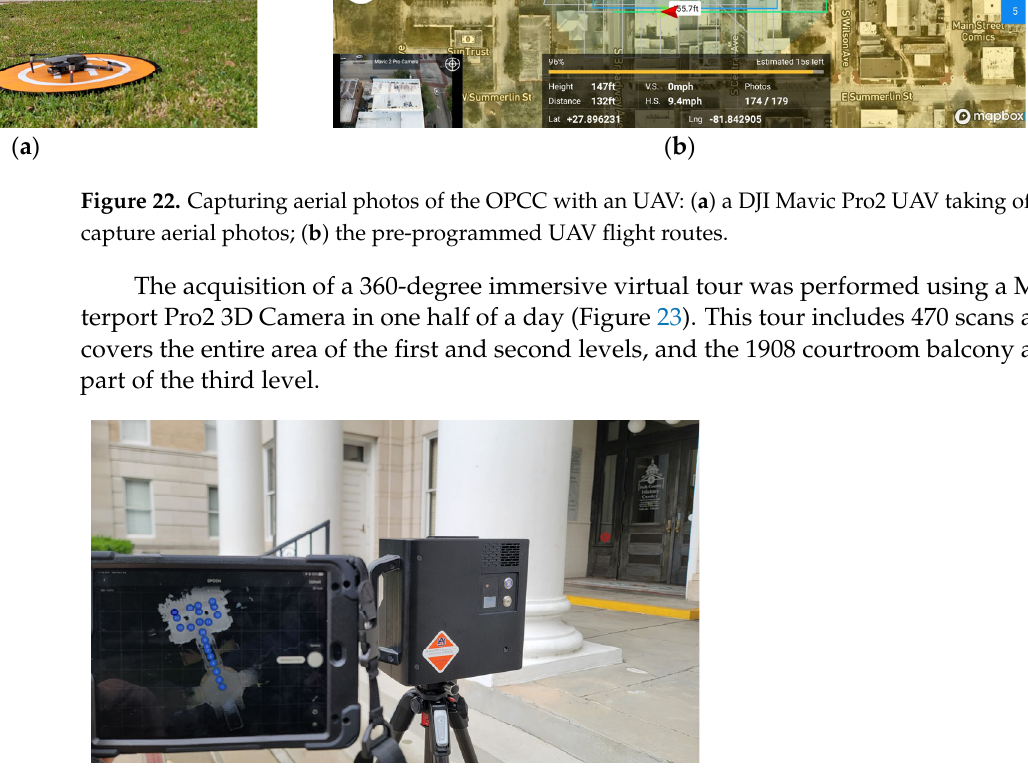
Figure 23. Capturing 360 ‐ degree photos to create a virtual tour of the OPCC with a Matterport Pro2 3D camera.